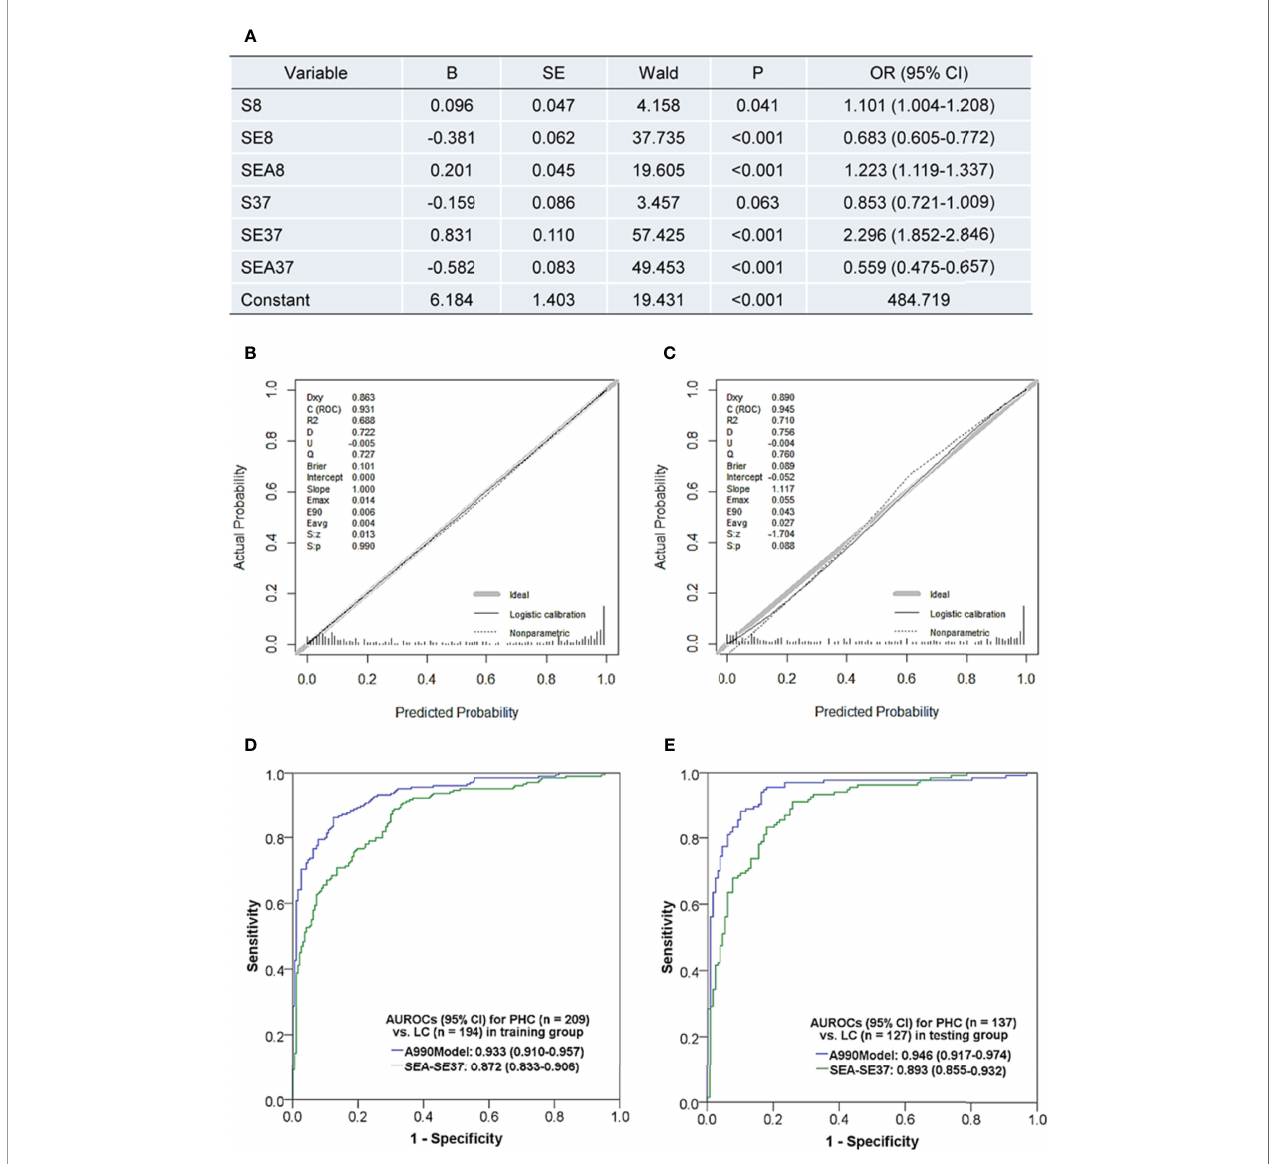
FIGURE 4 | Diagnostic model based on the triple serum fl uorescence indicators of aptamer AP-HCS-9-90 and its evaluation. (A) Variables and their information in the diagnostic model. (B, C) Calibration curves of the model in the training group (B) and testing group (C) . (D, E) Receiver operator characteristic curves of the model in the training group (D) and testing group (E) . Abbreviations in fl uorescence indicators: S, serum; E, EvaGreen; A, aptamer; 8, 8°C; 37, 37°C. Fluorescence indicator indicates the serum fl uorescence intensity under a speci fi c condition; for example, SEA37 represents the serum fl uorescence intensity at 37°C after incubation with EvaGreen and aptamer. B, regression coef fi cient; SE, standard error; OR, odds ratio; AUROC, the area under the receiver operator characteristic curve; CI, con fi dence interval; PHC, primary hepatic carcinoma; LC, liver cirrhosis; A990Model, the diagnostic model based on the six original fl uorescence indicators of aptamer AP-HCS-9-90; SEN, sensitivity; SPE, speci fi city; ACC, accuracy; PPV, positive predictive value; NPV, negative predictive value; PLR, positive likelihood ratio; NLR, negative likelihood